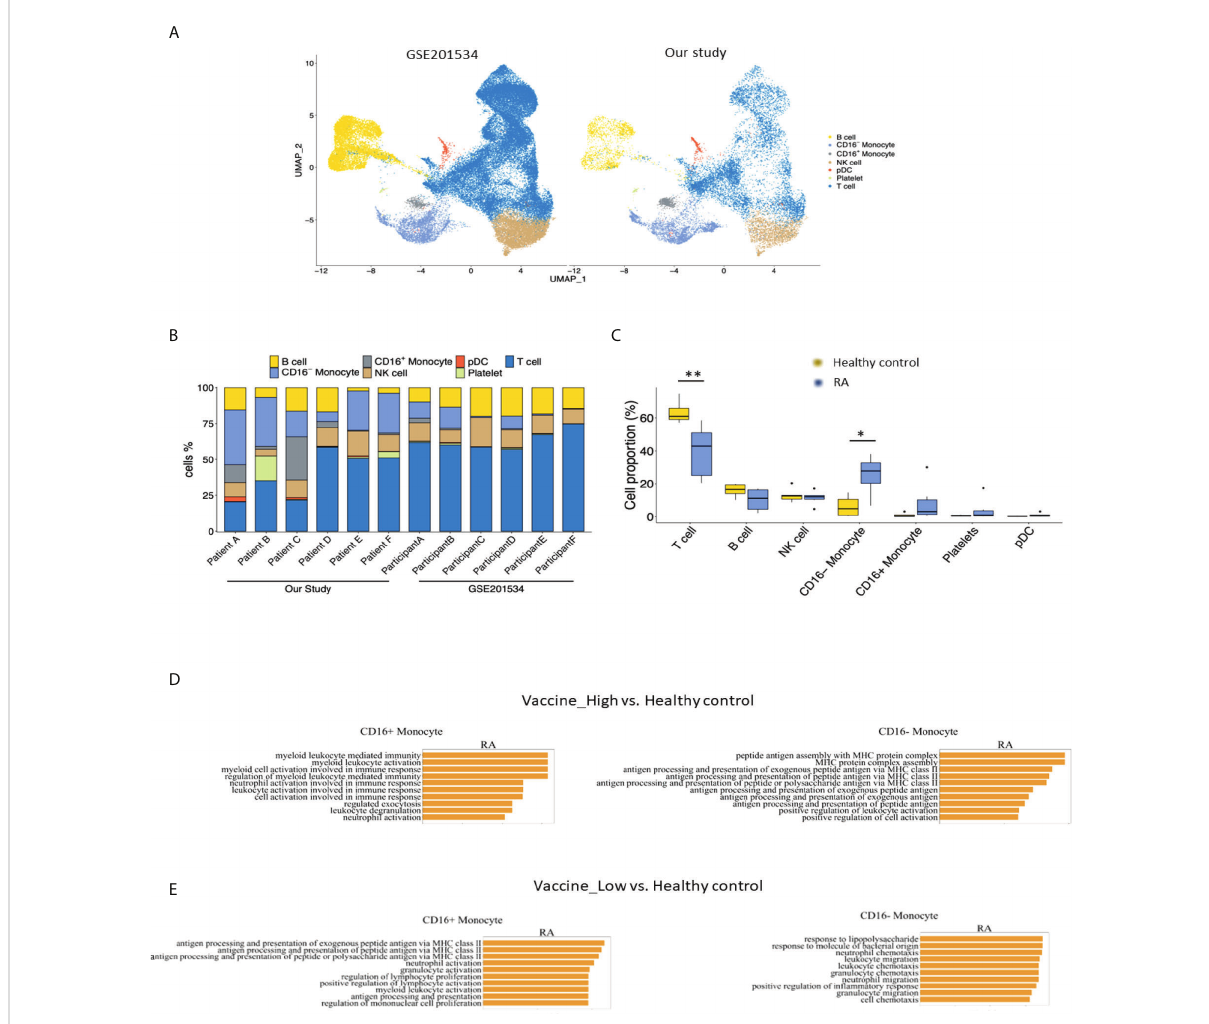
FIGURE 3 Comparisons of (A) cell atlas of peripheral blood mononuclear cells, (B) the proportions of cell types from each participant and (C) healthy controls from GSE201534 vs. patients with rheumatoid arthritis from our study. Pathway analysis of CD16+ and CD16-monocyte between (D) high anti-SARS-CoV2-IgG antibody group and (E) low anti-SARS-CoV2-IgG antibody group from our study vs. healthy control from GSE201534.